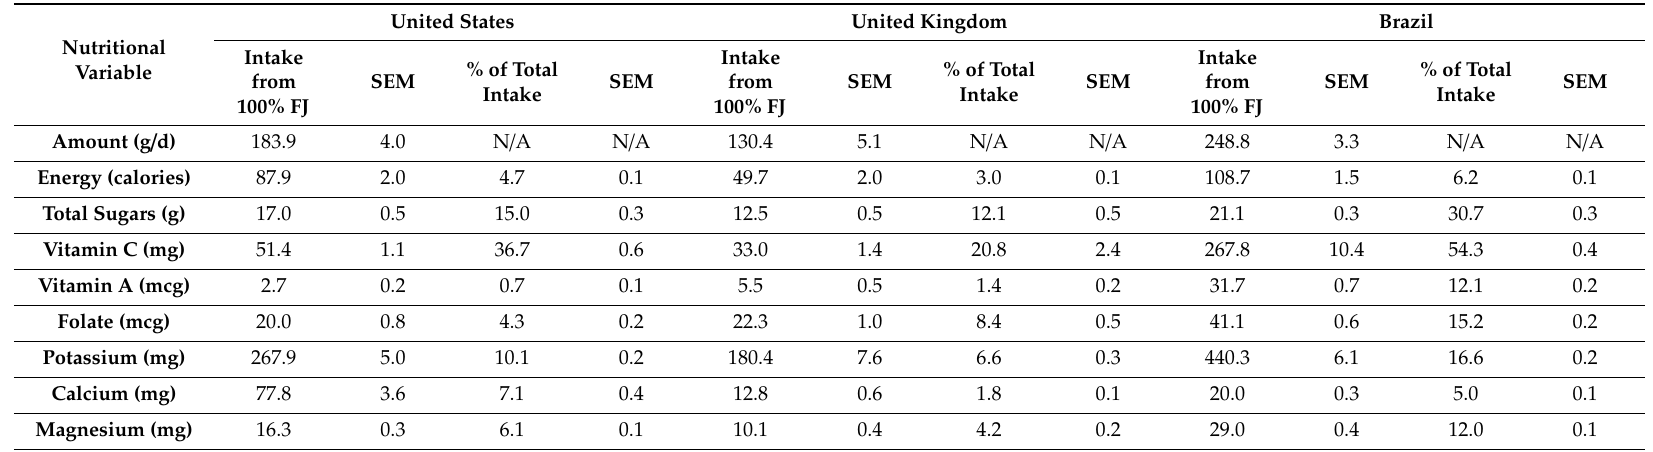
Table 1. Mean intakes of 100% FJ and contribution of 100% FJ to daily nutrient intakes in individuals reporting the consumption of 100% FJ in the U.S., UK, and Brazil. Nutritional